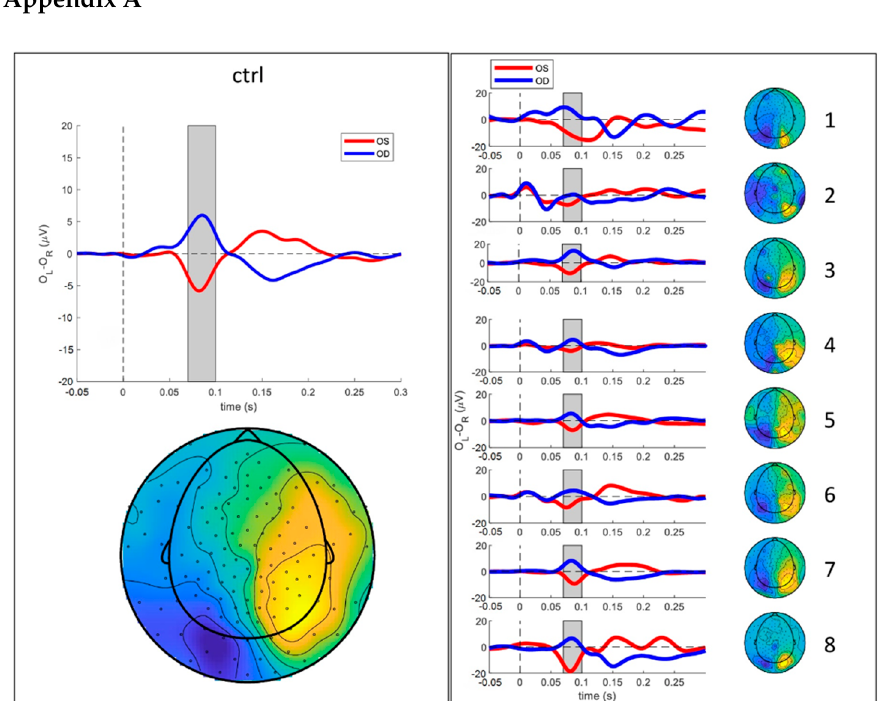
Figure A1. Single-subject misrouting effects. Left panel shows the typical interhemispheric asymmetry for a control albino patient. The plot shows the differential (O L –O R ) activity for OS (red) and OD (blue). The lower topoplot shows the difference between OS and OD from 0.07 to 0.1 s (grey area), confirming the presence of an interhemispheric difference mostly expressed over occipital electrodes. Right panel is the same as the left panel but for each patient from the current study.